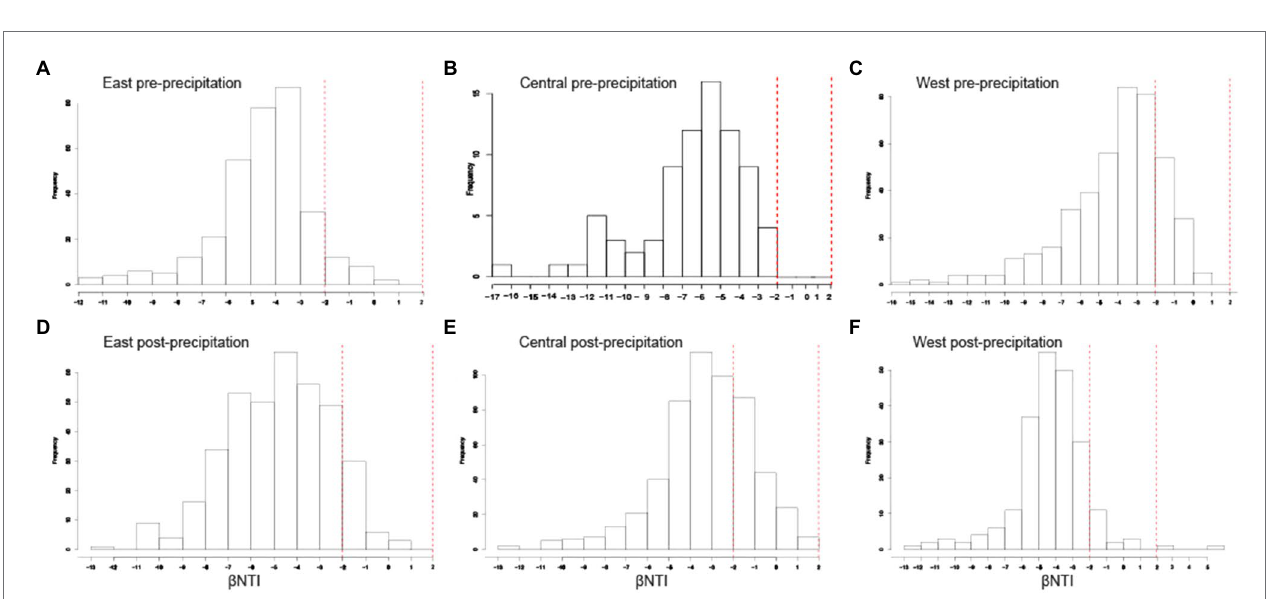
FIGURE 3 | Beta diversity depth-dependent clustering increased with landscape wetting. Non-metric multidimensional scaling of pre-precipitation (A-C) and post-precipitation (D-F) samples plotted as Bray-Curtis matrix. Permutational multivariate ANOVA (PERMANOVA) performed on individual slopes nested for depth was significant for all time points (pre- and post-precipitation).